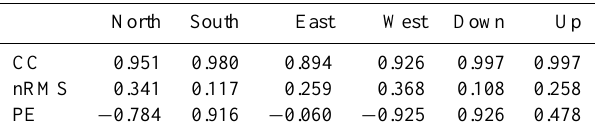
Table 2. Three metrics computed on the basis of the values in Fig.